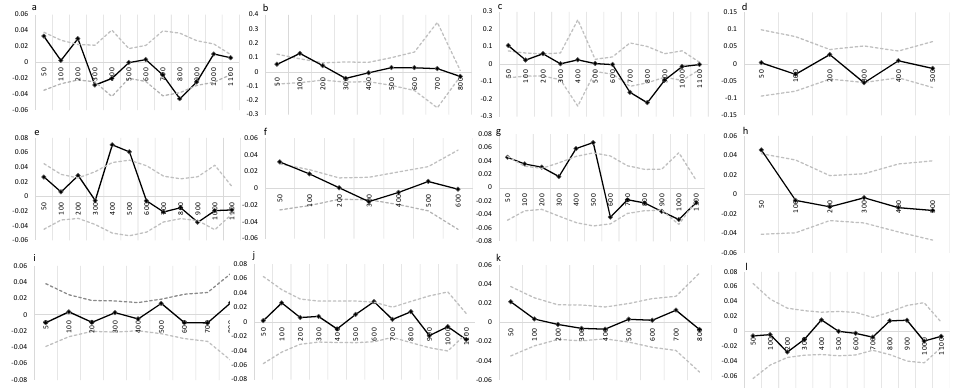
Figure 4. Spatial structure through autocorrelograms using kinship coefficient ( F ij) [33] with a 50 m first distance and consecutive 100 m distance class. ( a ) H adults; ( b ) C adults; ( c ) H saplings; ( d ) C